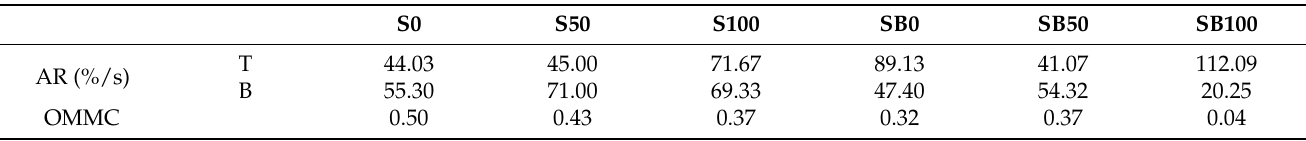
Table 4. The results of moisture management testing for standard (non-cationized) cotton fabric presented as mean value.